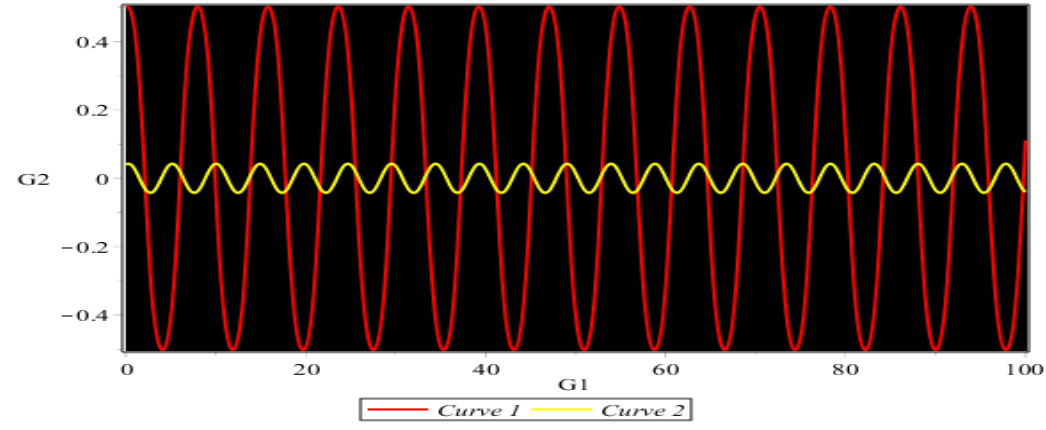
Figure 4. Sensitivity presentation for curve 1 at (0.5, 0.03) and curve 2 at (0.04, 0.02).